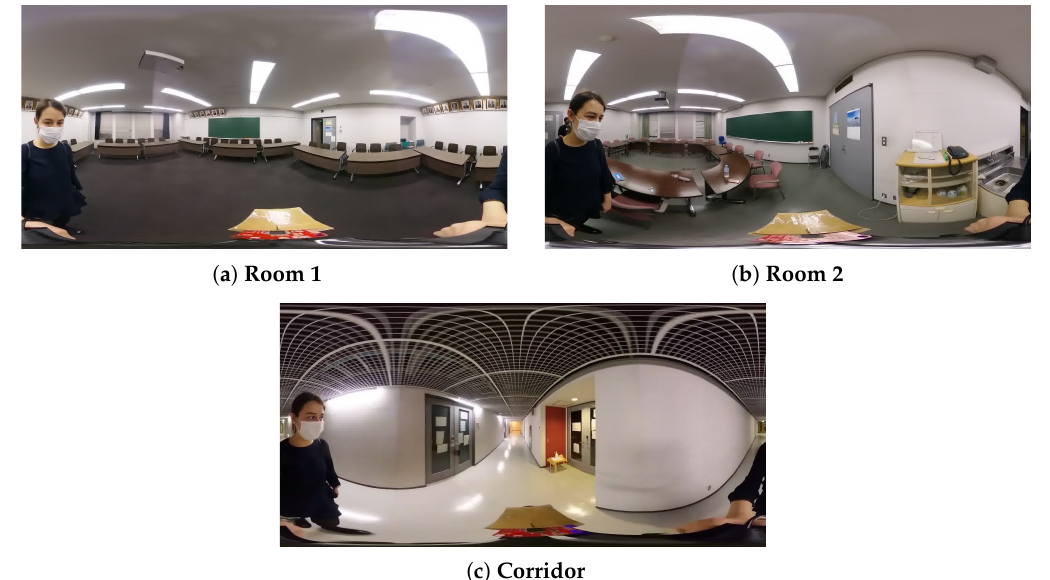
Figure 4. Symmetrical environment experiment setting. ( a ) Starting room, ( b ) final room, ( c ) connecting corridor.